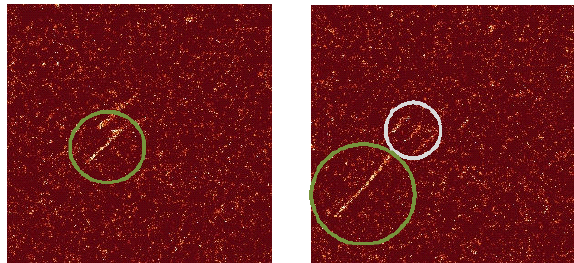
Figure 4: Luminescence in the range of 410–650 nm of gold parti- cles on glass as measured by the confocal microscope CLSM, using pulsed (75 fs) excitation at 700 nm. The images are recorded in se- quence (time interval 1.3 s) and the image size is 20 µ m. The tracks in the green circles follow each other, while the track in the gray circle is